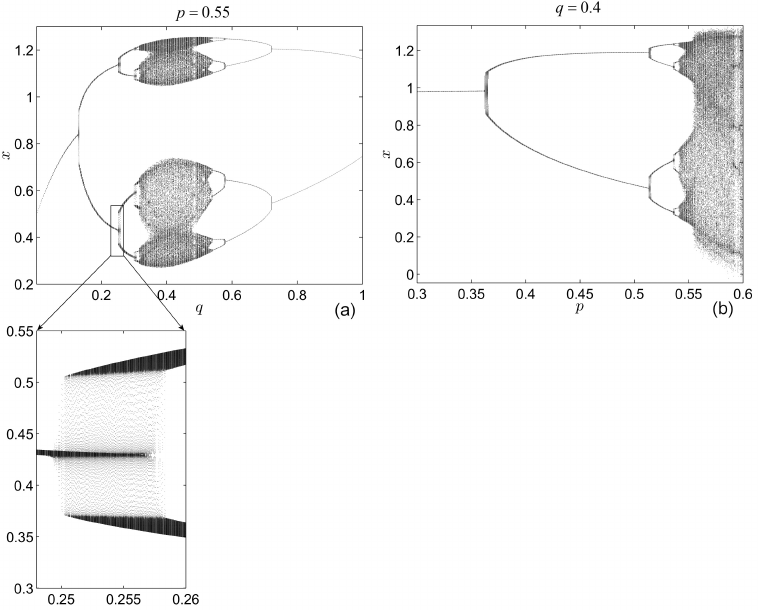
Figure 2. ( a ) The BD for p = 0.55 vs. q obtained for ( x 0 , y 0 ) = ( 0.1,0.3 ) ; ( b ) the BD and for q = 0.4 vs. p ∈ ( 0.3,0.6 ) for ( x 0 , y 0 ) = ( 0.1,0.3 )